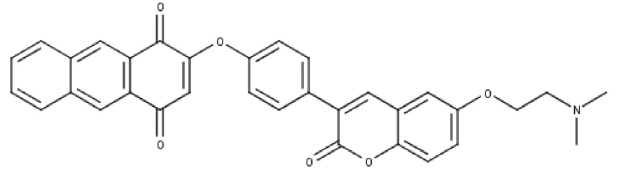
FIGURE 7 - The hybrid derivative quinone–coumarin that targets the enzymes GAPDH and